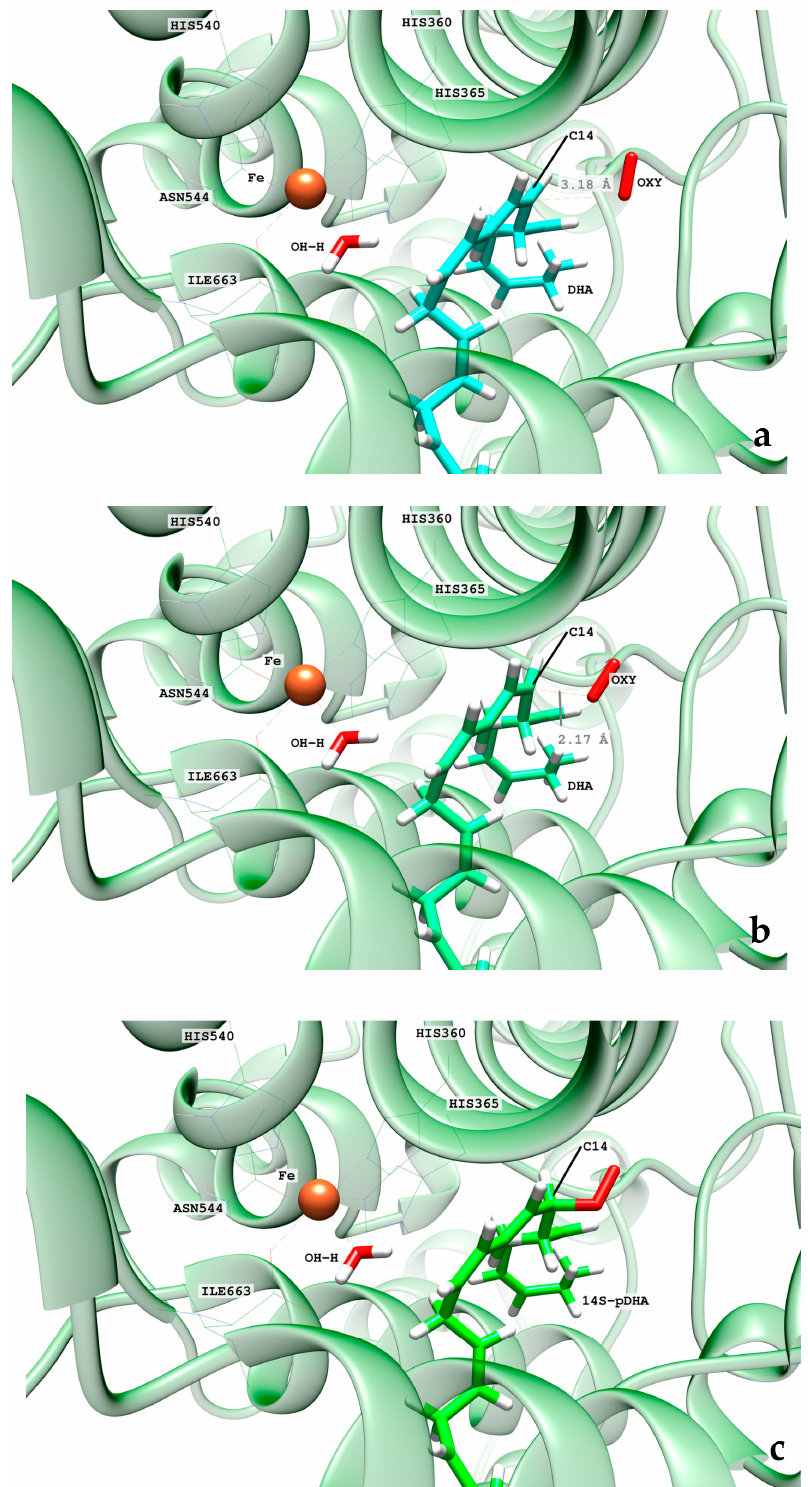
Figure 13. Images of the optimized reactant ( a ), transition state structure ( b ), and product ( c ) of the O 2 addition at C 14 (frame 8721) in hALOX12. The distances between C 14 and the attacking oxygen atom are given for the reactant and transition state structures.